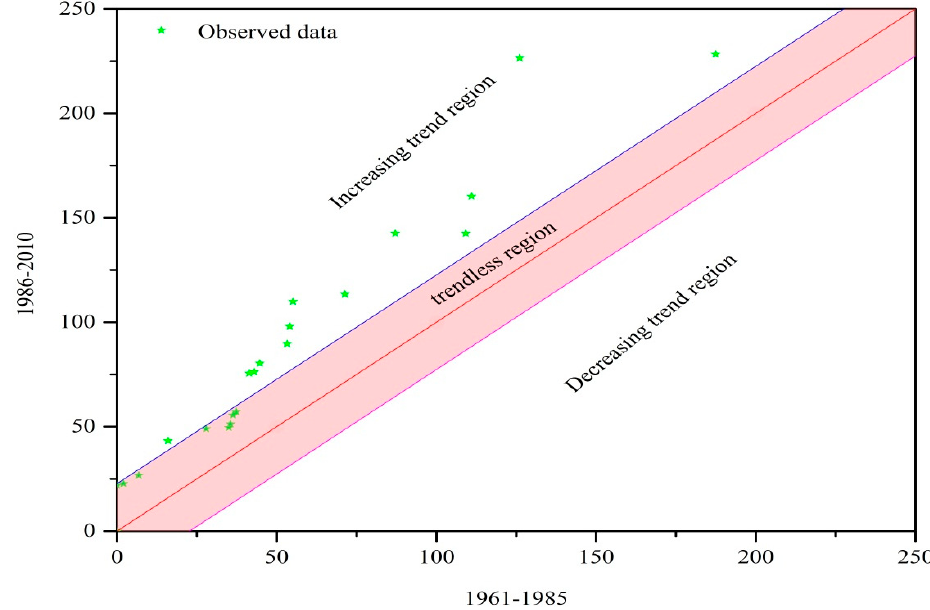
Figure 4. Illustration of decreasing, increasing and trendless region in the hydrological time series .